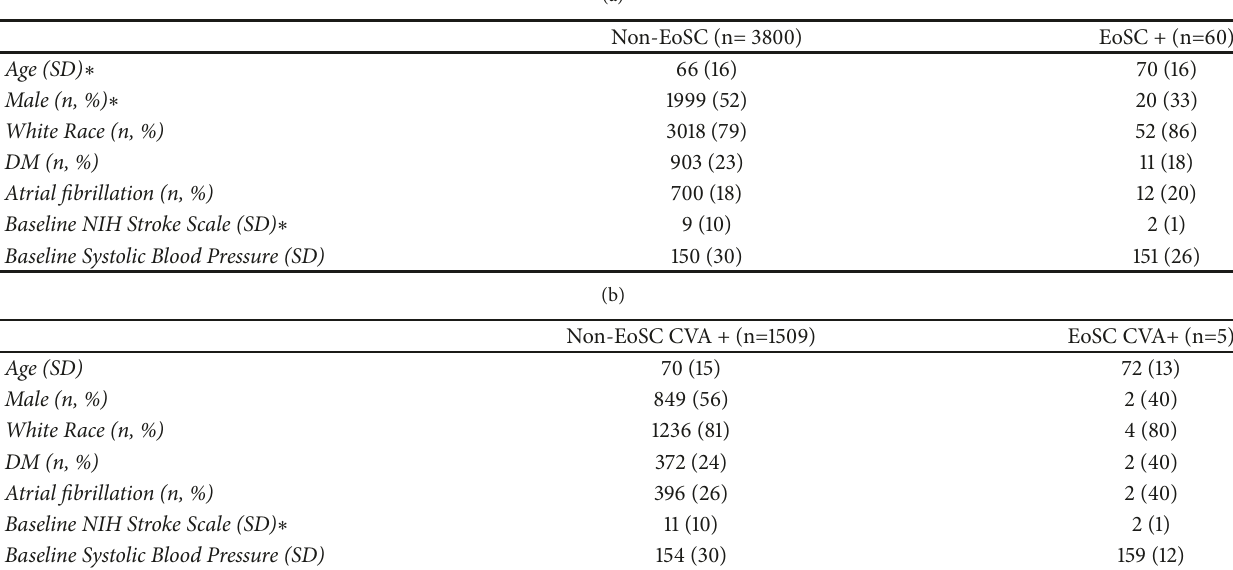
Table 1: Patient Demographics (EoSC & EoSC CVA+): Definition 1.